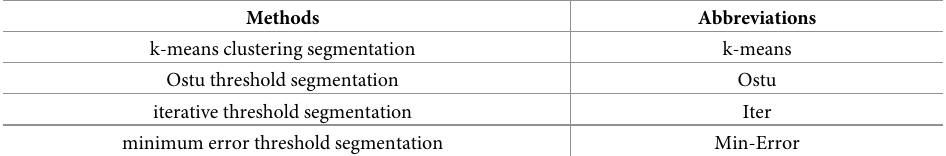
Table 7. Segmentation methods and abbreviation.